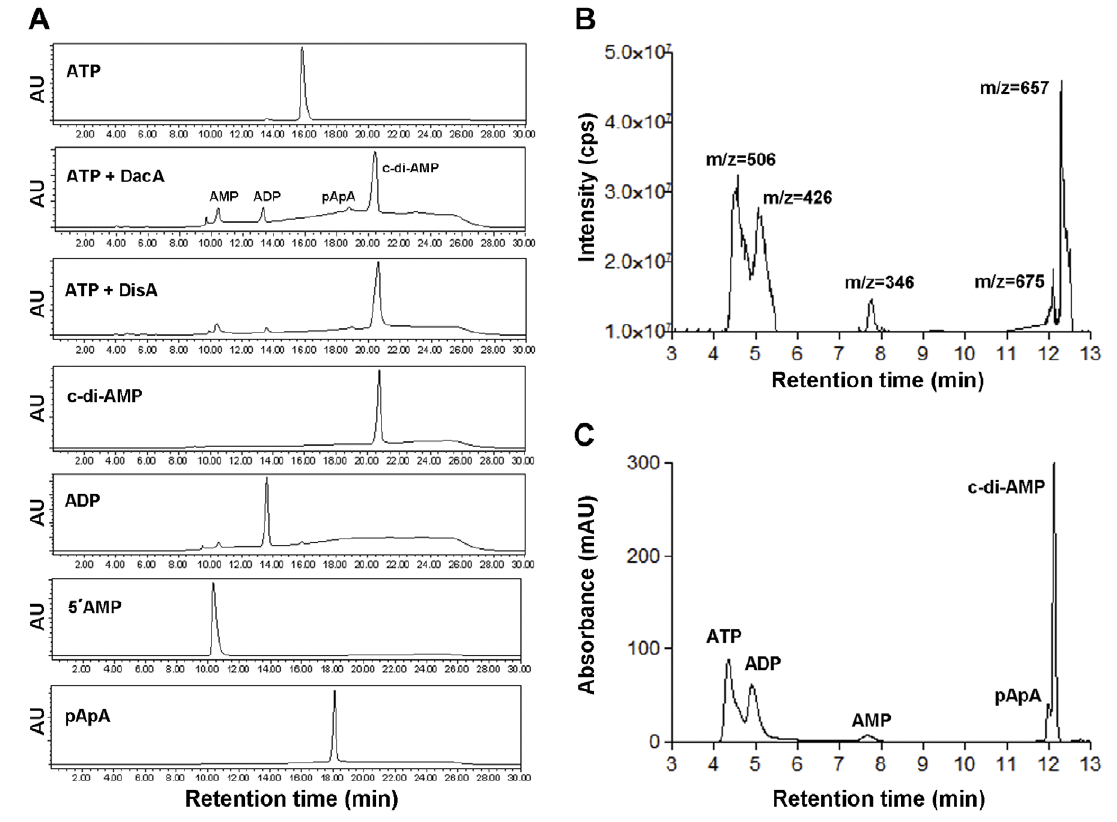
Figure 2. Determination of DacA’s activities using HPLC and LC-MS. (A) Analysis of the products from reaction of ATP with DacA using HPLC. Reaction of ATP with DisA was included as a positive control. The reactions were carried out as described in the Methods. ATP, c-di-AMP, ADP, AMP and pApA standards were also analyzed under the same conditions. (B and C) LC/UV/MS profiles of the products formed by DacA with ATP. The products were detected by monitoring EMS at mass range from 100 to 1000 amu (B) or monitored by UV absorption at 254 nm (C).